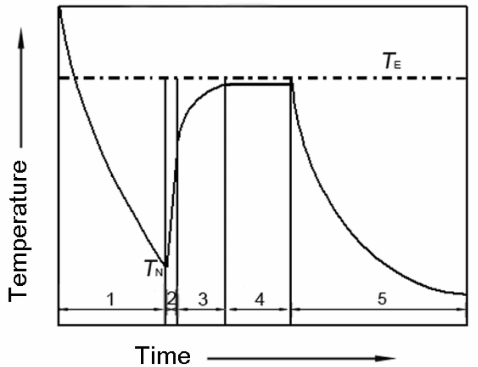
Figure 1. Schematic illustration of a cooling curve during the solidification of undercooled eutectic